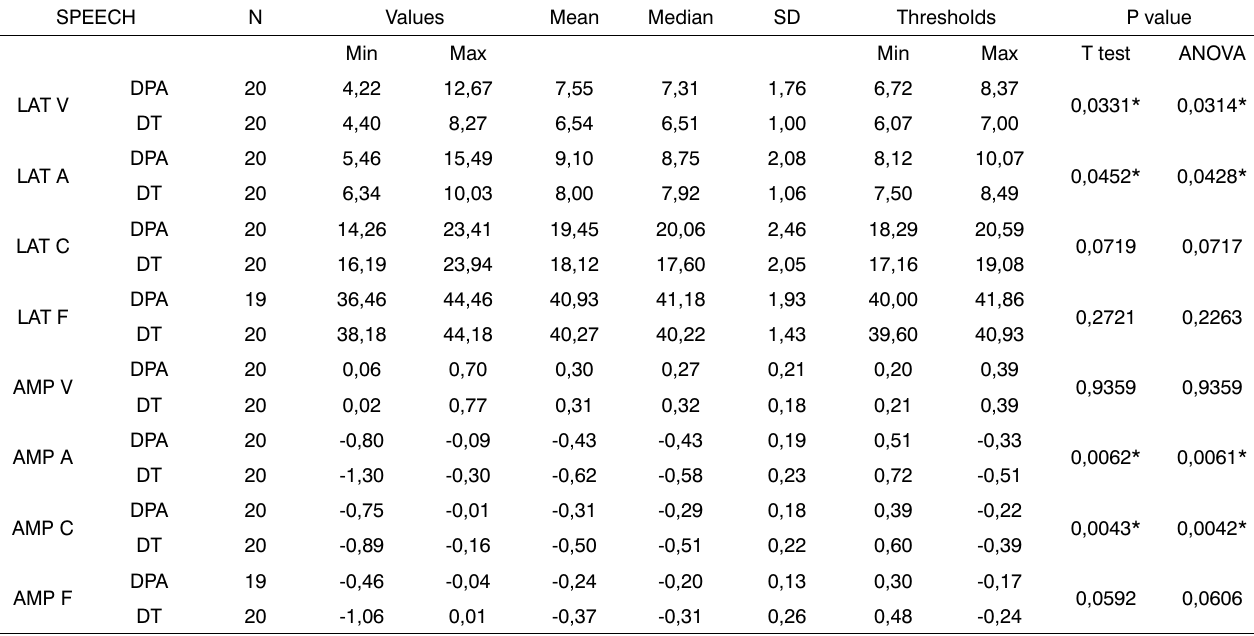
Table 2. Speech stimulus - minimum, maximum, mean, median, standard deviation (SD), confidence interval and p values of the latencies